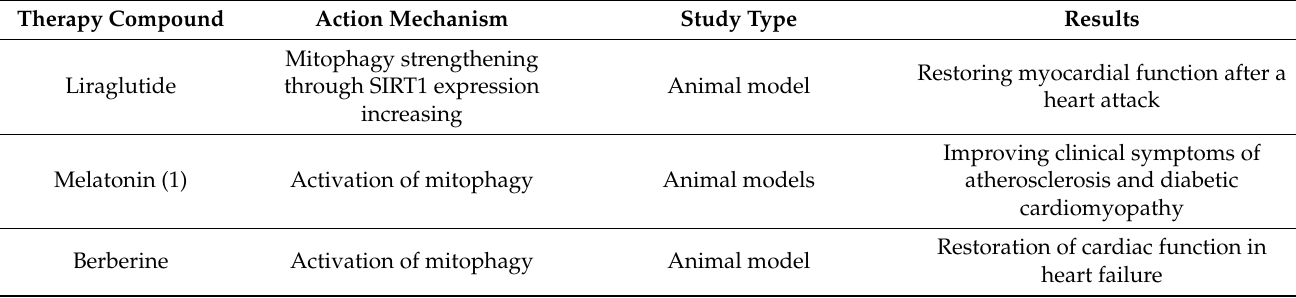
Table 2. Modulation of mitochondrial dynamics for CVD